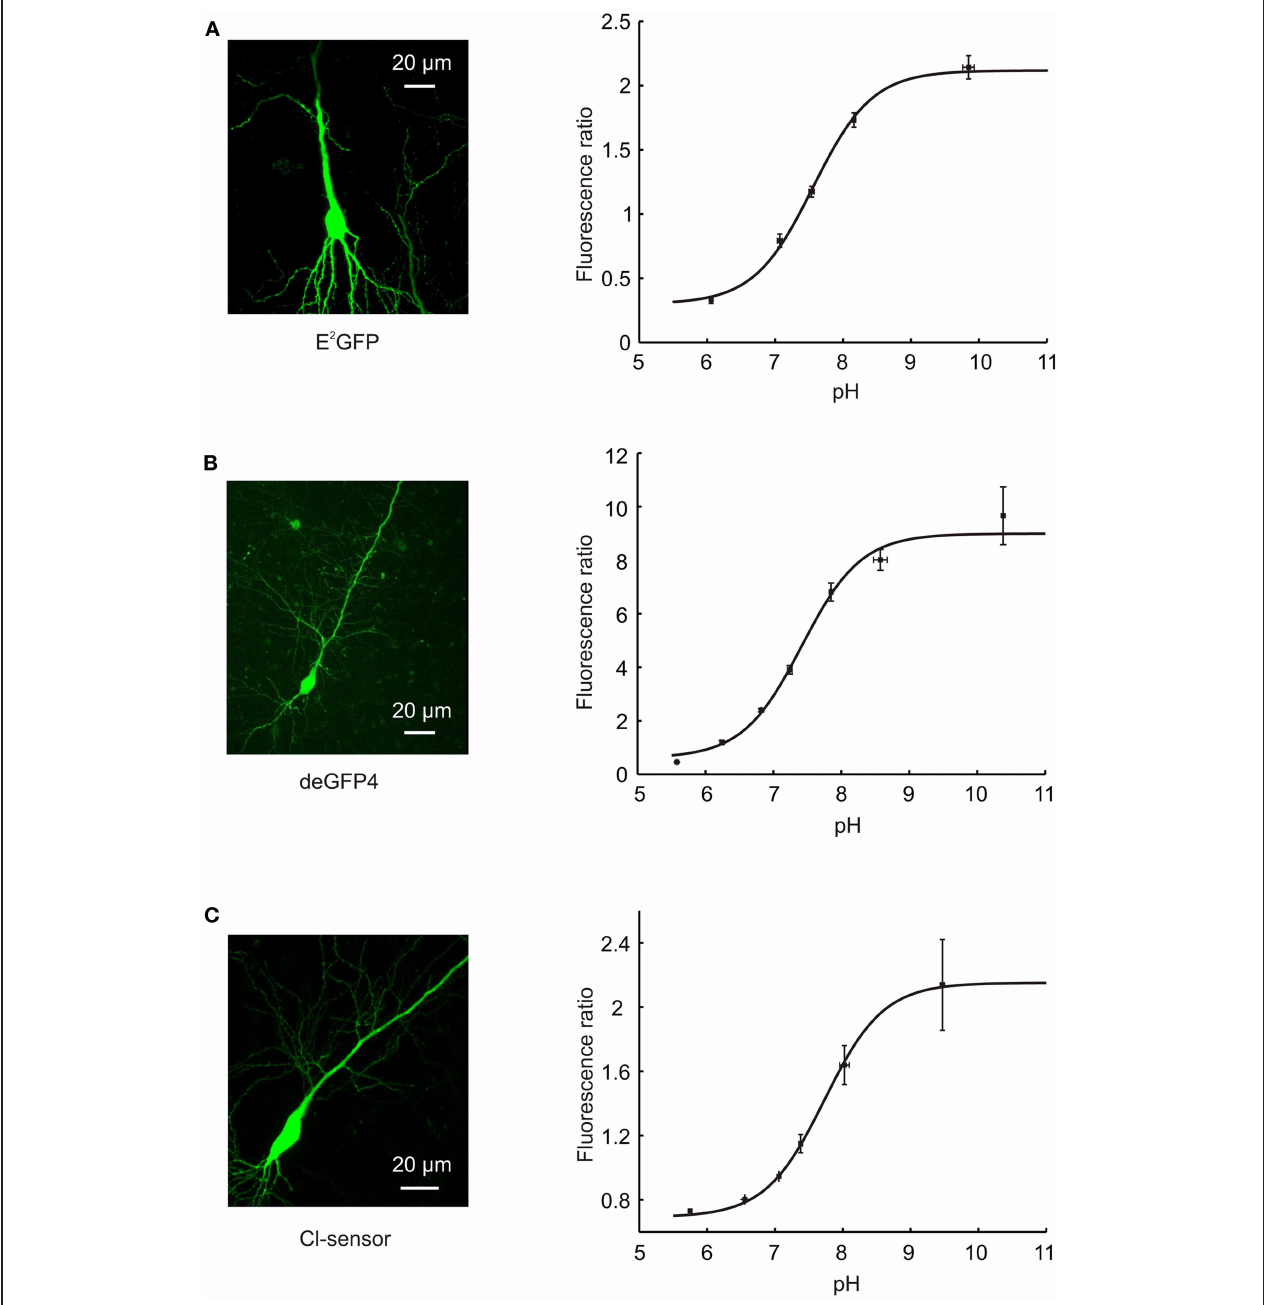
FIGURE 2 | Calibration of pH-sensitive GFP variants. (A) A confocal image of a hippocampal CA3 pyramidal neuron expressing E 2 GFP (left). Calibration curve relating the fluorescence ratio of E 2 GFP expressing neurons to their intracellular pH (right; n = 4). E 2 GFP was used as an excitation ratiometric reporter, with excitation at two separate wavelengths (458 and 488nm) and emitted light collected from a single window (500–550 nm). Intracellular pH was systematically varied by controlling extracellular pH in the presence of a proton-permeable ionophore (see Materials and Methods). Data was fit using established equations (Grynkiewicz et al., 1985; Arosio et al., 2010; see Materials and Methods) and pK a was found to be 7.56. (B) A confocal image of a hippocampal CA3 pyramidal neuron expressing deGFP4 (left). Calibration curve relating the